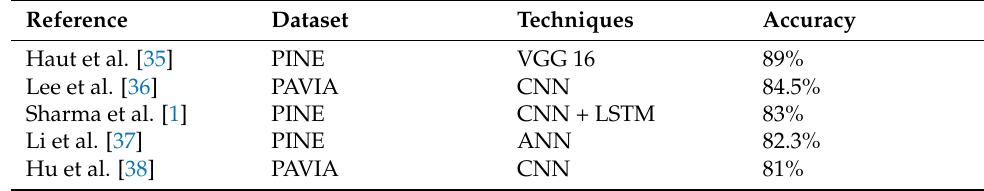
Table 1. Comparative Analysis.